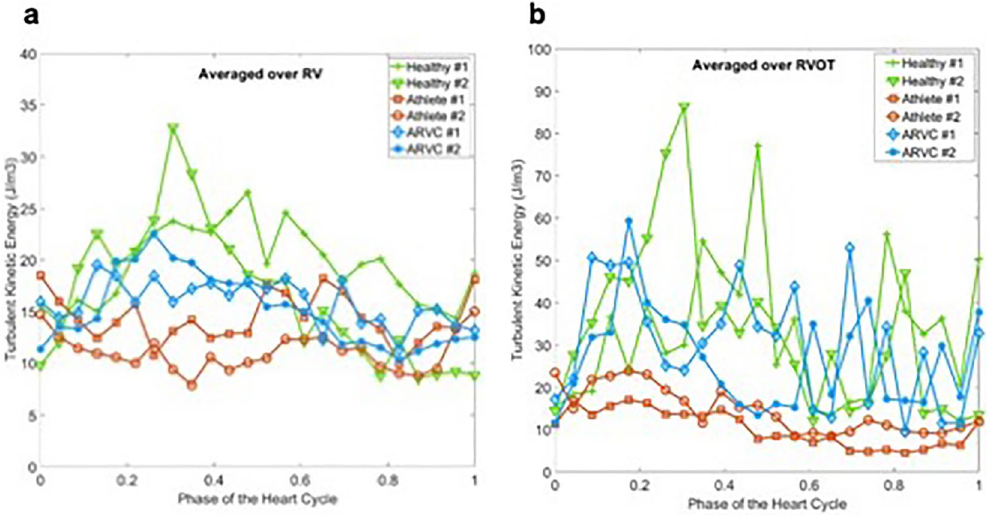
Figure 3. ( a ) Time evolution of turbulent kinetic energy (TKE) averaged over RV for healthy probands, athletes and patients with ARVC. ( b ) Time evolution of turbulent kinetic energy (TKE) averaged over RVOT for healthy probands, athletes and patients with